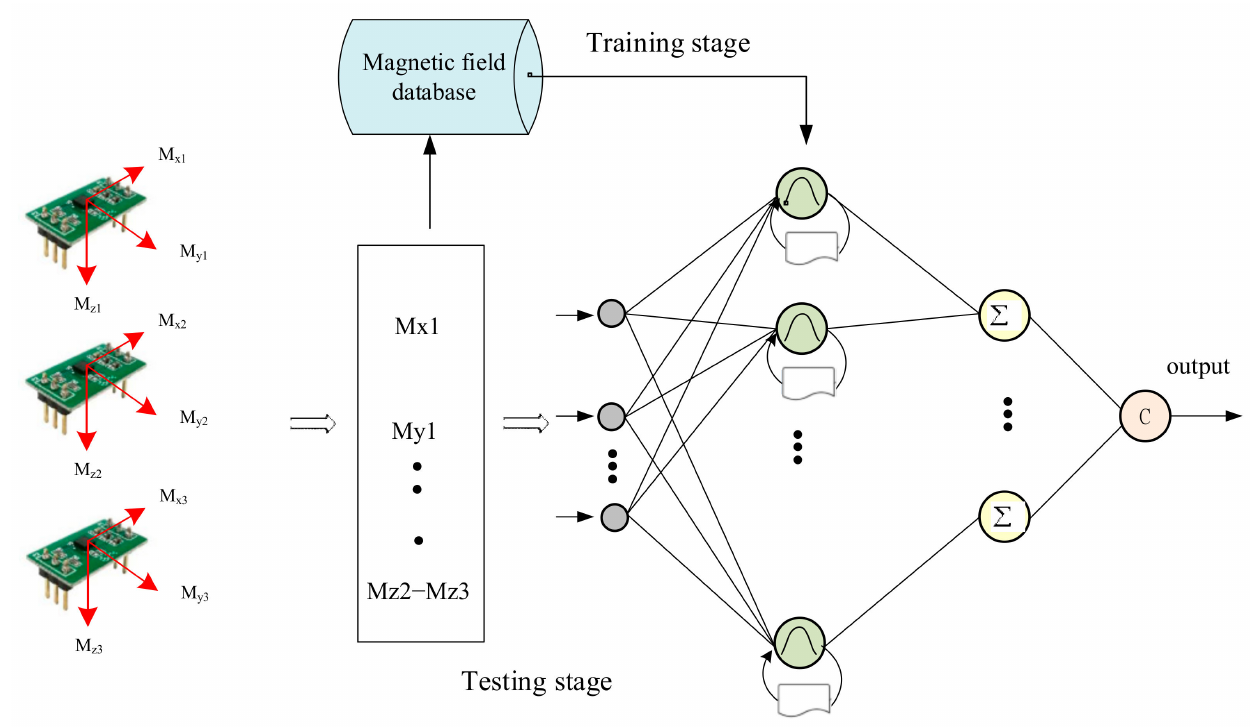
Figure 8. RPNN fingerprint map classifier